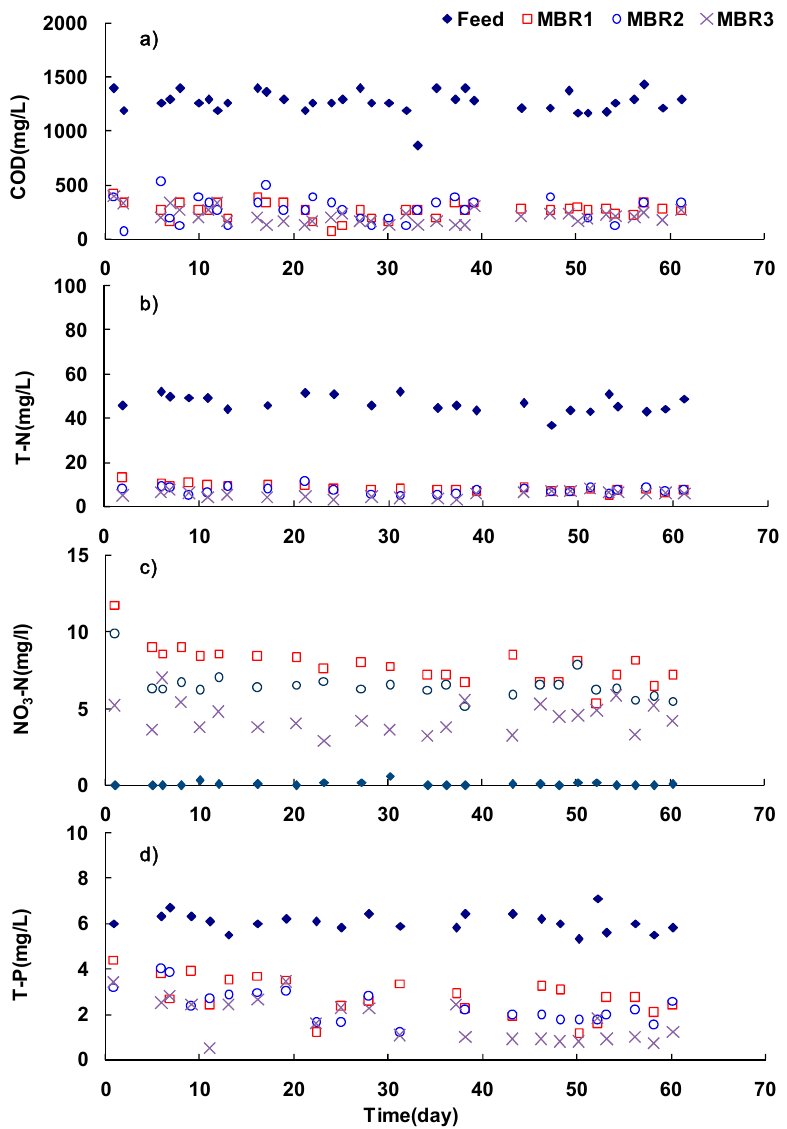
Figure 2. Water quality change over the experimental period ♦ , in fl uent □ , MBR1 ○ , MBR2: ( a ) COD; ( b ) T-N; ( c ) nitrate nitrogen; ( d ) T-P.